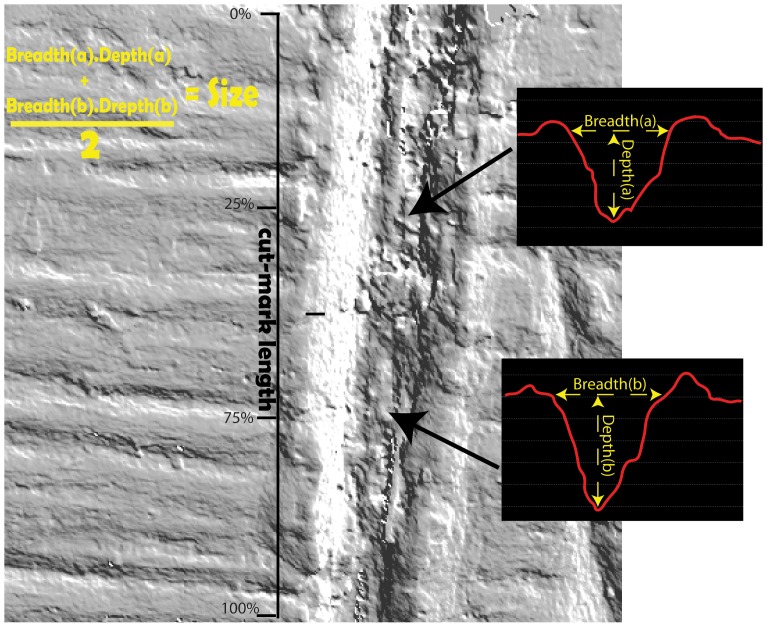
Demonstration of how mean cross-sectional size was measured on terrestrial and aquatic bone surface modifications using three-dimensional models rendered in usoft analysis software.